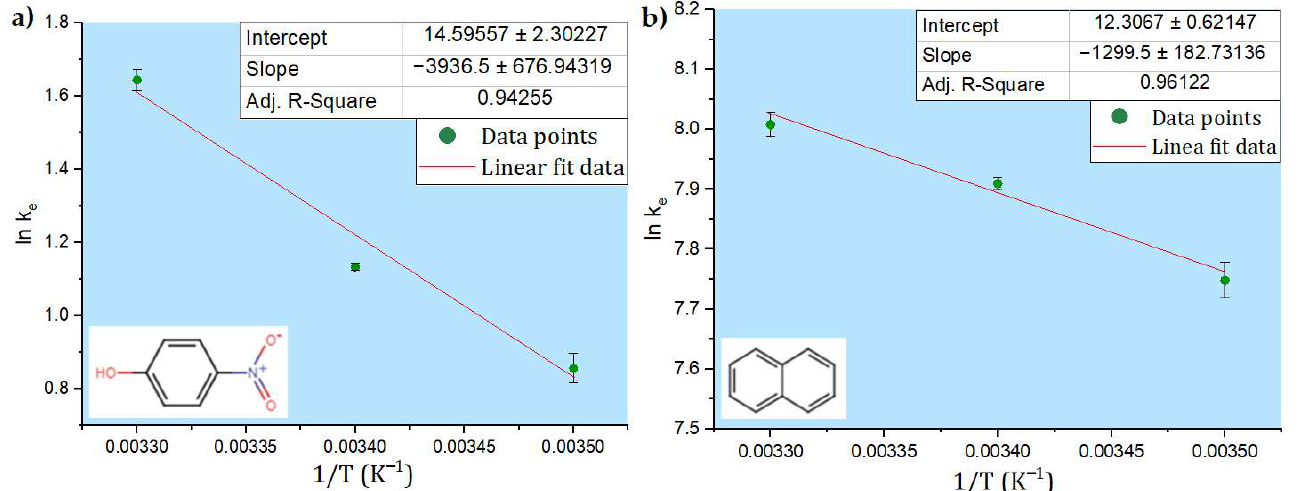
Figure 4. Kinetics for the adsorption of model pollutants at variable temperatures (5, 15, and 22 °C): ( a ) PNP and ( b ) naphthalene. The solid line represents a visual guide to illustrate the trend of the kinetic profile.